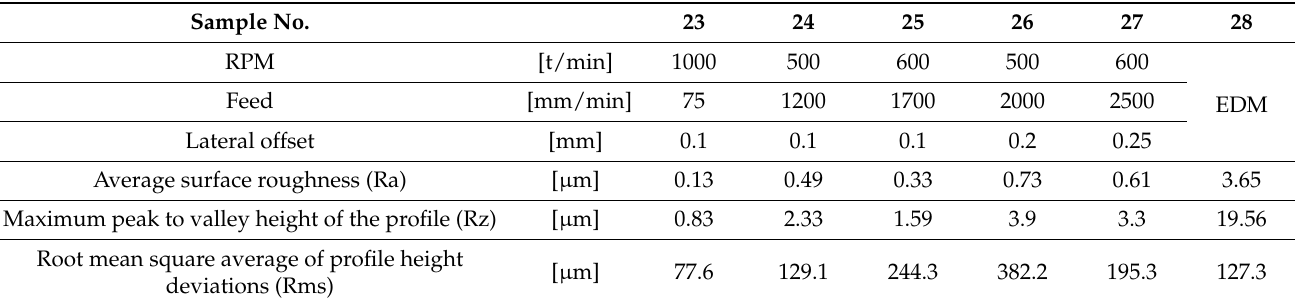
Figure 1. Samples with varying surface roughness conditions used in this study. Specimen 28 (right sample) was obtained by electro-discharge machining (EDM). Table 1. Material rotational speed and feed rates.